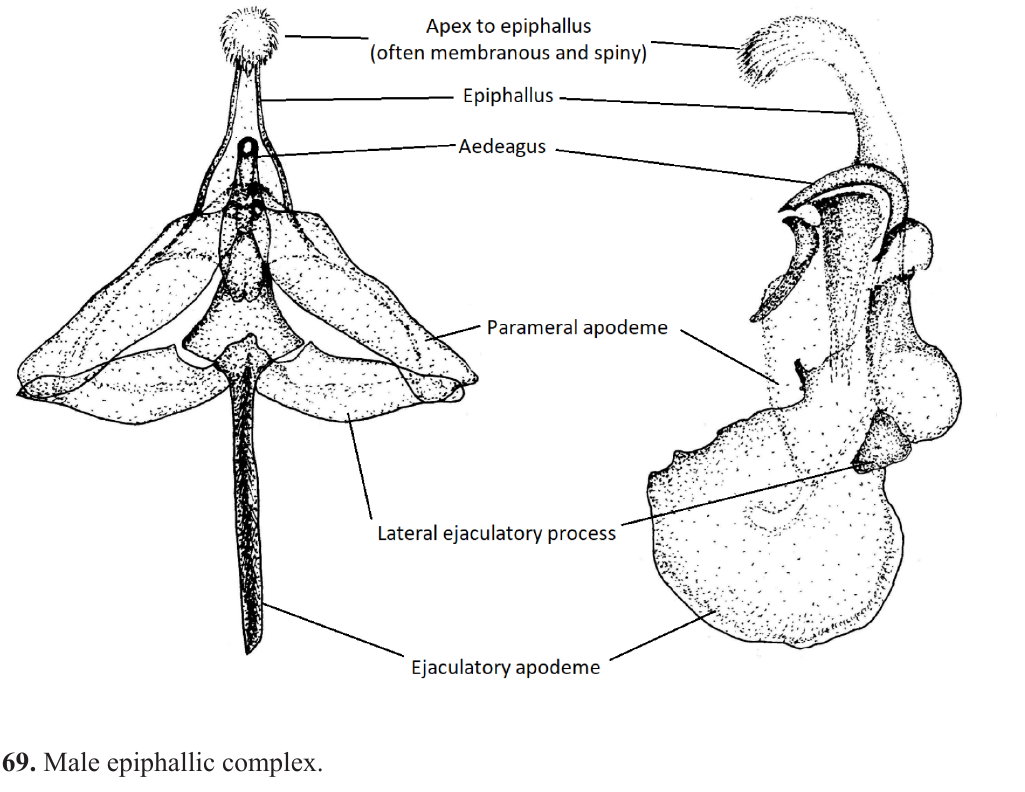
Fig. 69. Male epiphallic